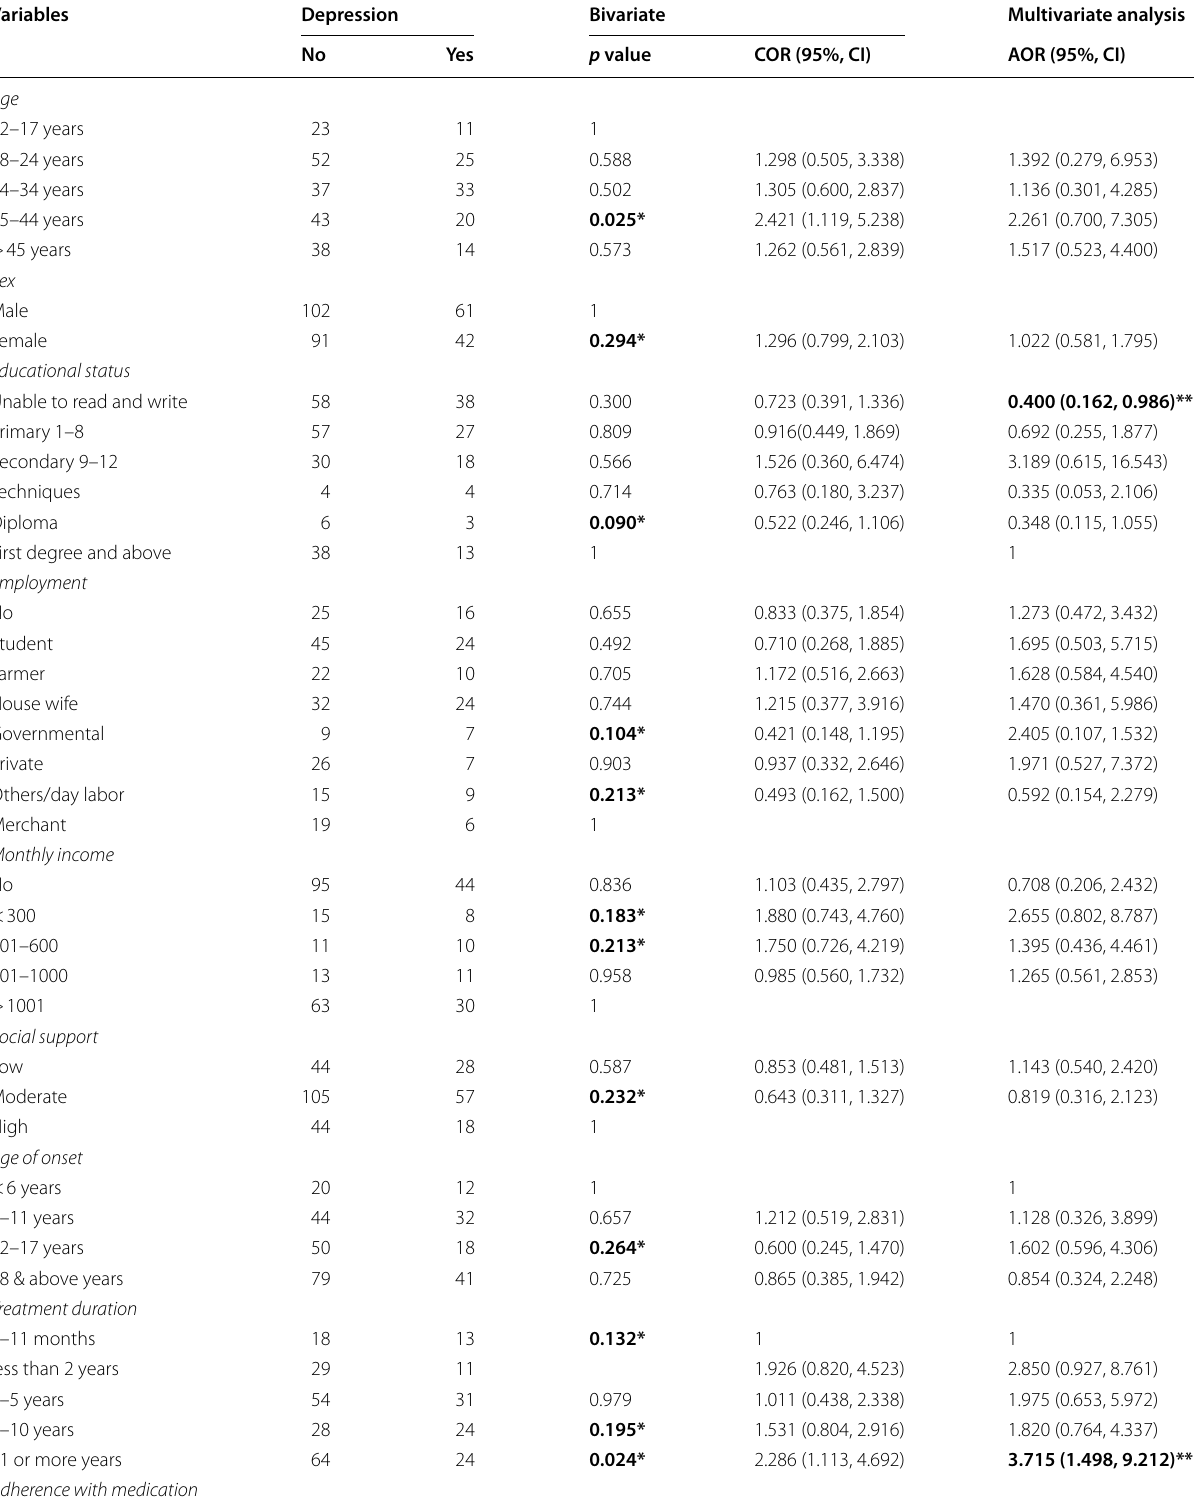
Table 4 Factors associated with depression in people with epilepsy (bivariate and multivariate analysis) for the study of the prevalence of depression and associated factors among epileptic patients in ACSH & MGH, 2019